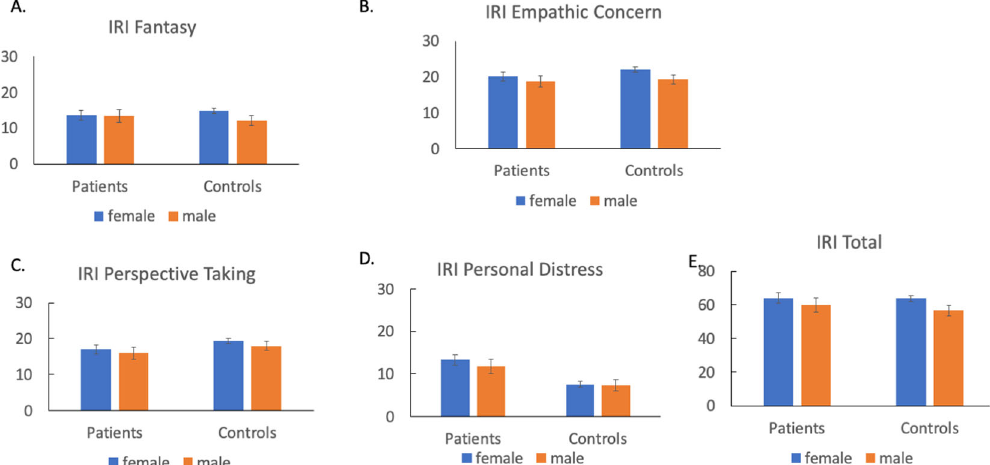
Fig. 2 Performance of patients and controls on the subjective social cognitive measure. A IRI fantasy, B IRI empathic concern, C IRI perspective taking, D IRI personal distress, and E IRI Total. Error bars indicate 95% con fi dence interval. IRI the Interpersonal Responsivity